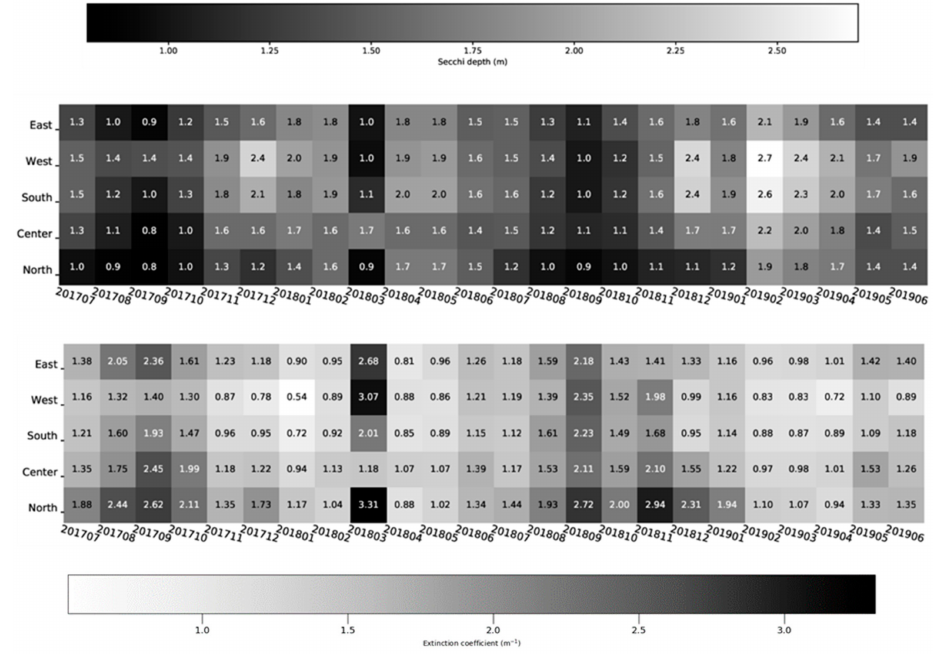
Figure 15. The 5th and 95th percentiles for SD (top) and KD (bottom),